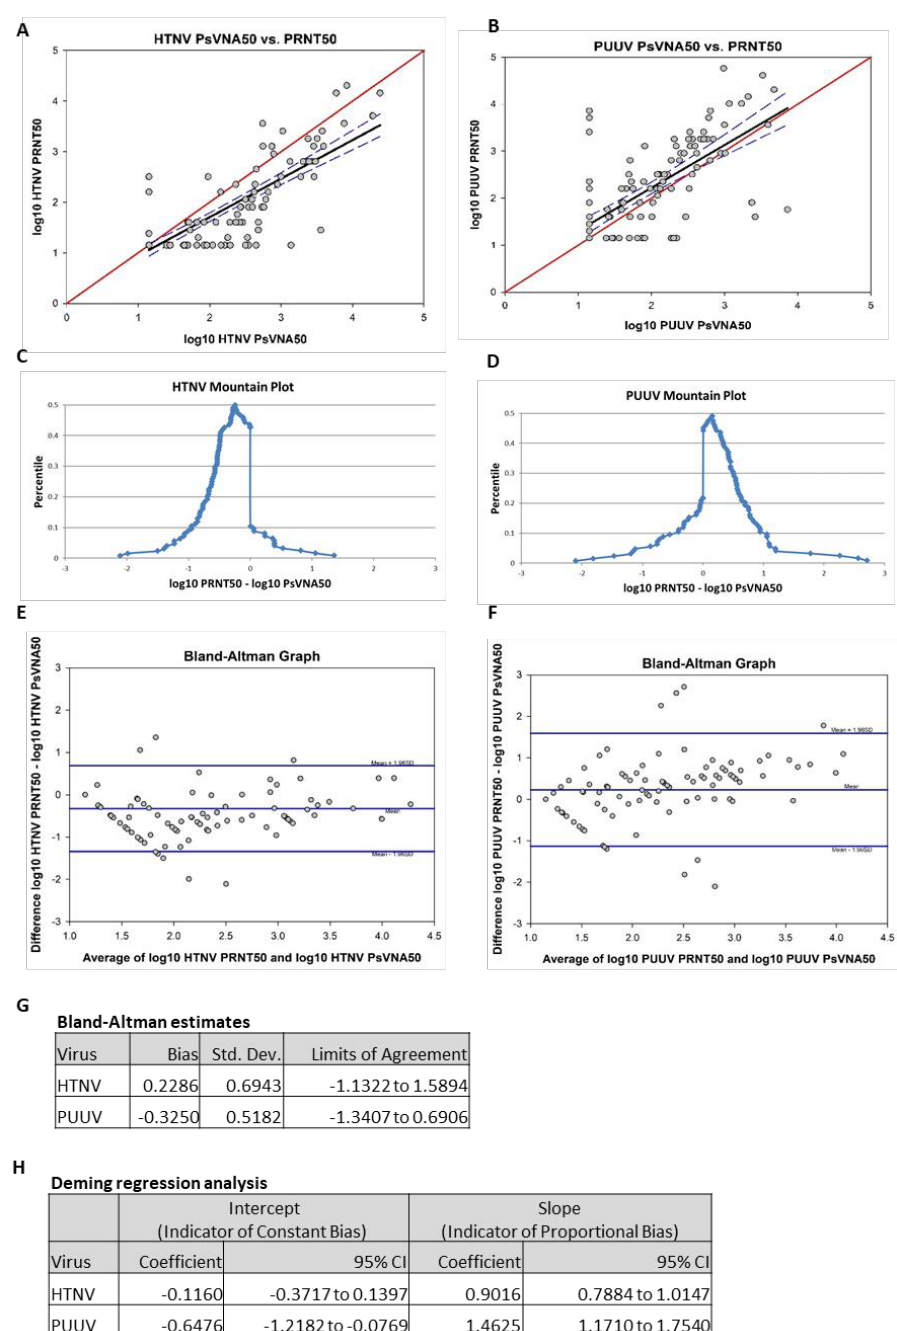
Figure 7. ( A , B ) In each graph, the black points represent the PRNT50-PsVNA50 pairs. The red line represents the ideal linear function of perfect correlation. The black line represents the observed linear function corresponding to the r value, and the blue lines represent the 95% confidence interval around the linear function. ( C , D ) In each graph, the blue dots represent the di ff erence between PRNT50 and PsVNA50 for each subject plotted against each observation’s percentile value. ( E , F ) In each graph, the black dots represent the di ff erence between PRNT50 and PsVNA50 plotted against the average of the PRNT50 and the PsVNA50 for each subject. Blue lines represent the mean bias and limits of agreement. ( G ) The bias estimates and limits of agreement from the Bland–Altman analysis are shown. ( H ) The results of the Deming regression model are shown. If the confidence interval for the intercept contains 0, then it can be concluded that a constant bias does not exist between the two methods. If the confidence interval for the slope contains 1, then it can be concluded that a proportional bias does not exist between the two methods.